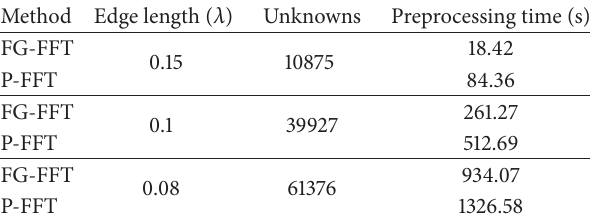
Table 4: The Preprocessing time in Example